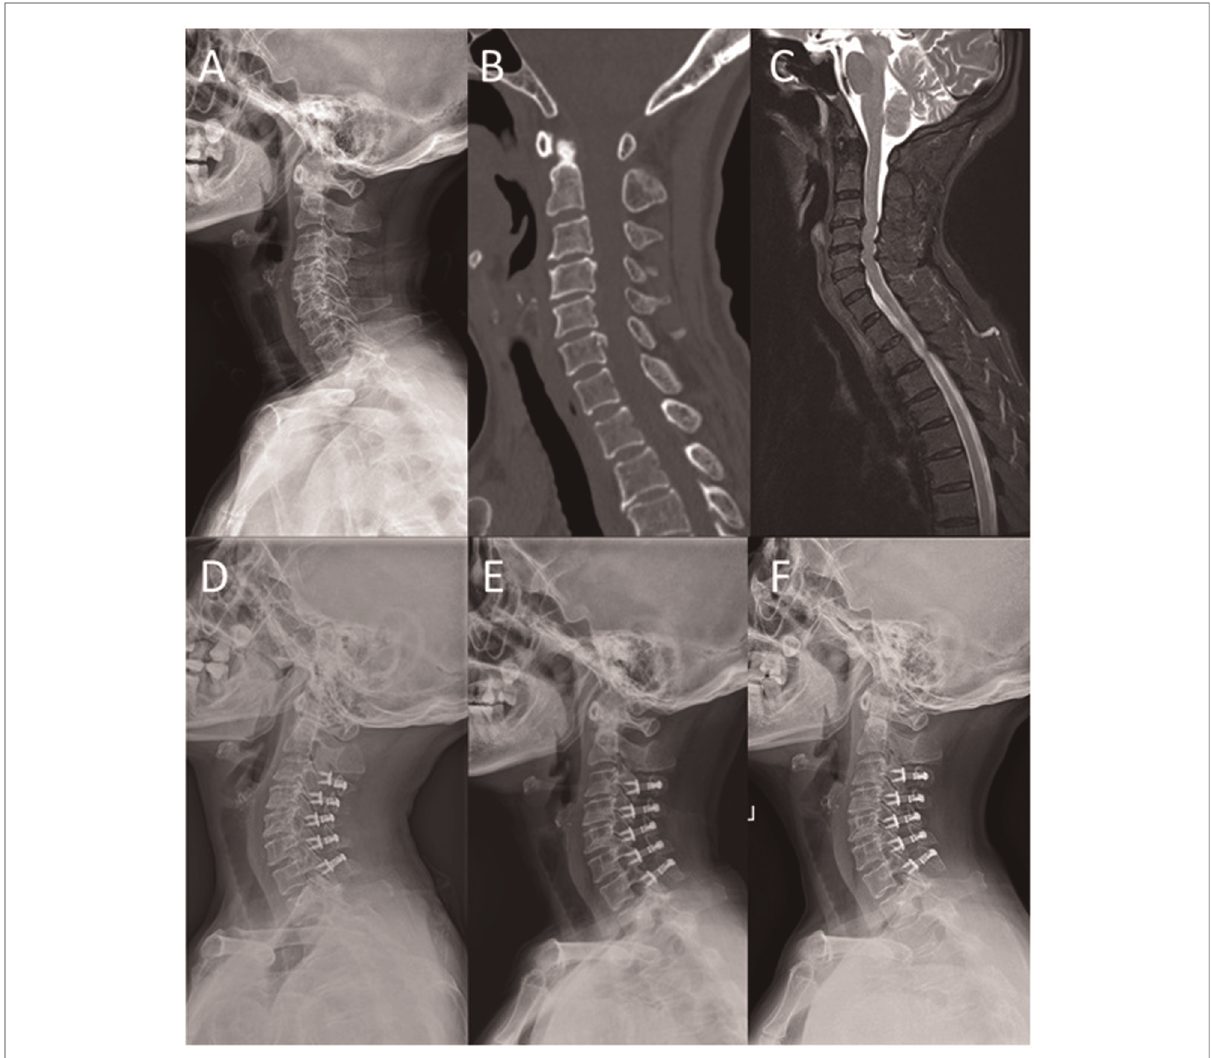
FIGURE 4 A 65-year-old female was treated with open-door laminoplasty. ( A ) X-ray lateral view before surgery; ( B ) sagittal CT scan before surgery; ( C ) sagittal fat-suppressed sequence in MRI before surgery; ( D ) postoperative X-ray lateral view; ( E ) X-ray lateral view at 1 month after surgery; and ( F ) X-ray lateral view at